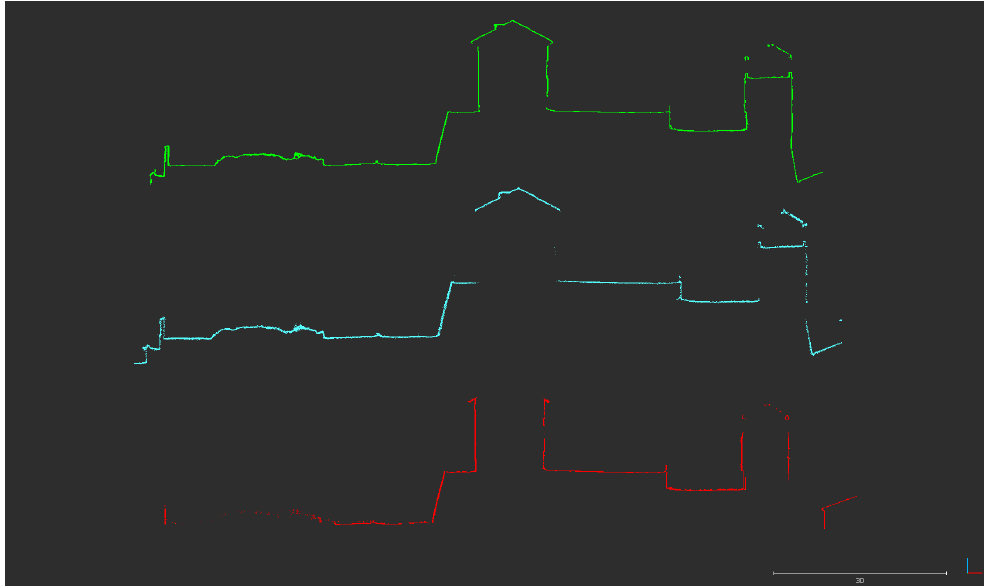
Figure 18. Extracted profile 1: P1 (green); L1 (cyan); SX10 (red). The registration and alignment started with the P1 data (Figure 19). The photogram- metric data was aligned with the SX10 data, set as reference. The ICP process was